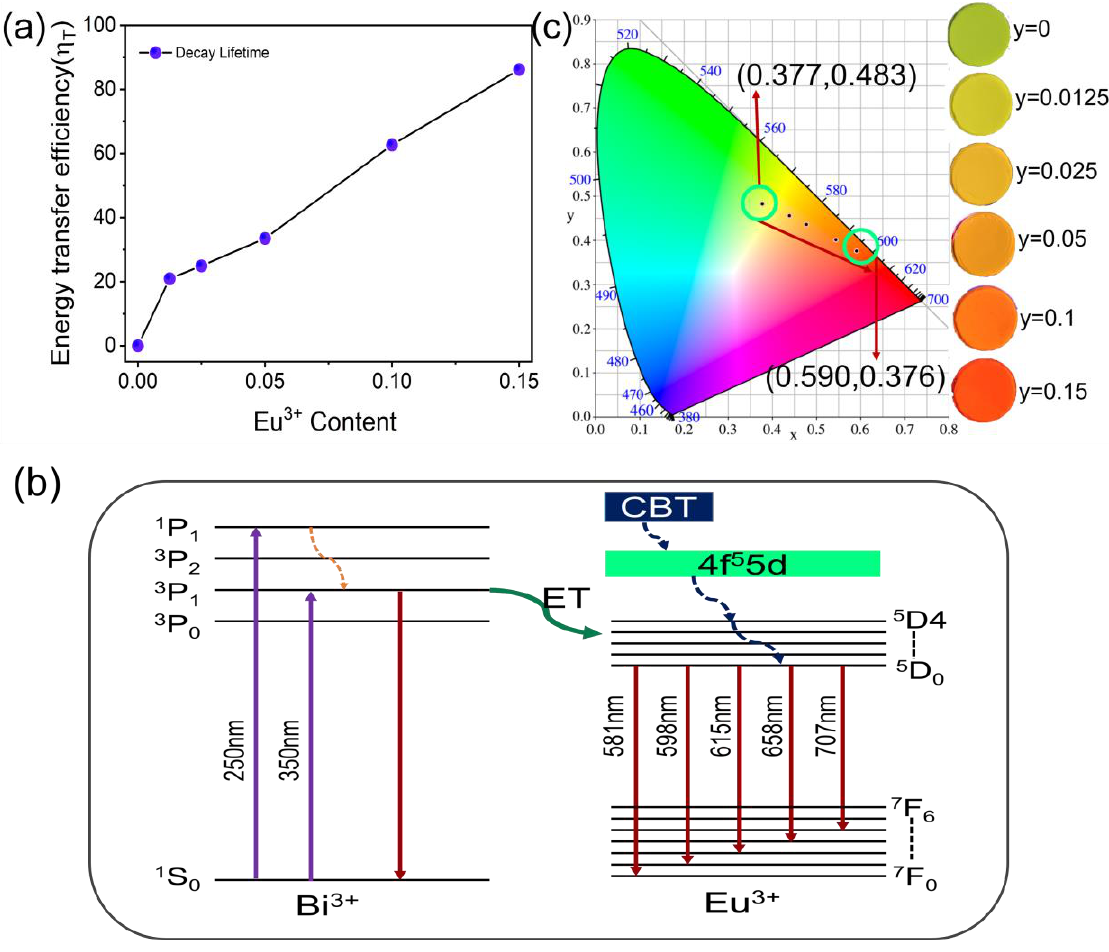
Figure 4. ( a ) Energy transfer efficiency of SLSO:0.06Bi 3+ , y Eu 3+ ; ( b ) schematic energy level diagram of Bi 3+ and Eu 3+ in SLSO; ( c ) color coordinates and luminescence photos of SLSO: Bi 3+ , y Eu 3+ .